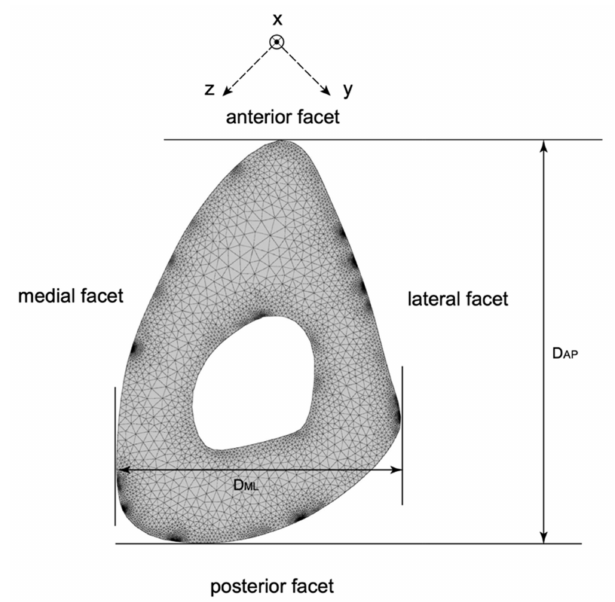
Figure 3. The cross-section at the mid-diaphyseal region of a human tibia showing the finite element mesh used to determine dispersion curves. Table 2. Comparison of tibial cross-section dimensions (in mm) at the diaphyseal mid-span. Mid-Span